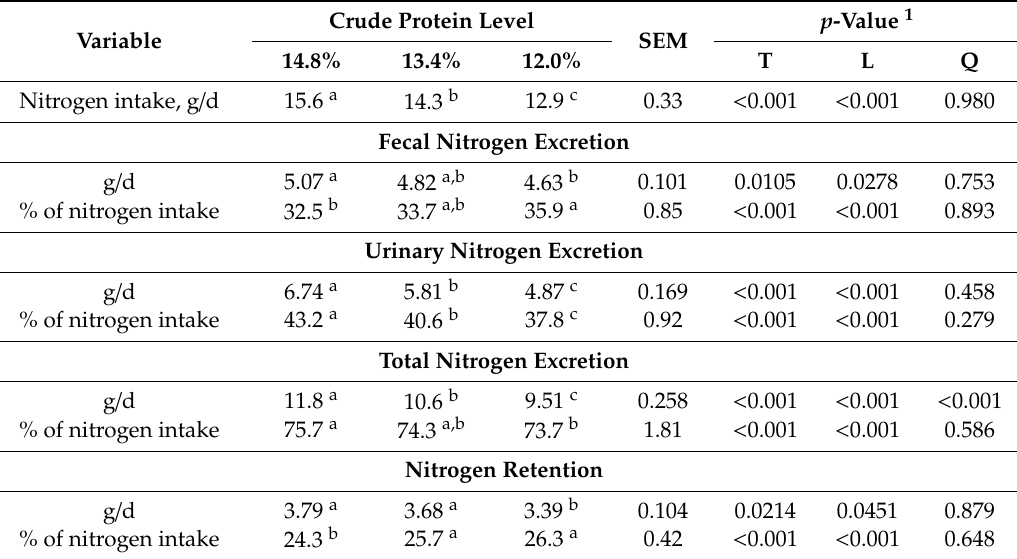
Table 4. E ff ects of low-protein diet on nitrogen balance in growing goat